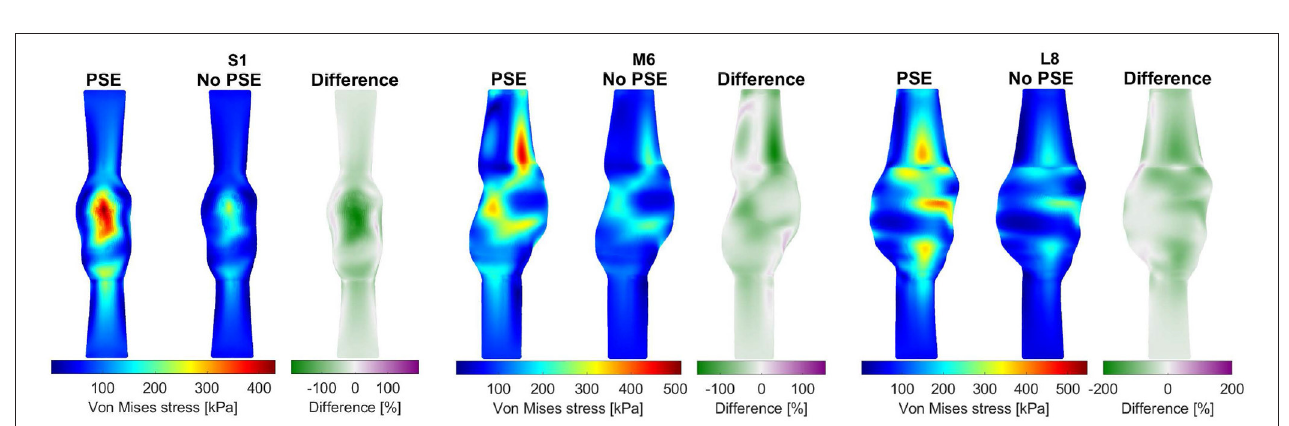
FIGURE 6 | Visualization of the systolic displacement resulting from the FSI simulations with and without PSE, and the difference in displacement for patients S1, M6, and L8.